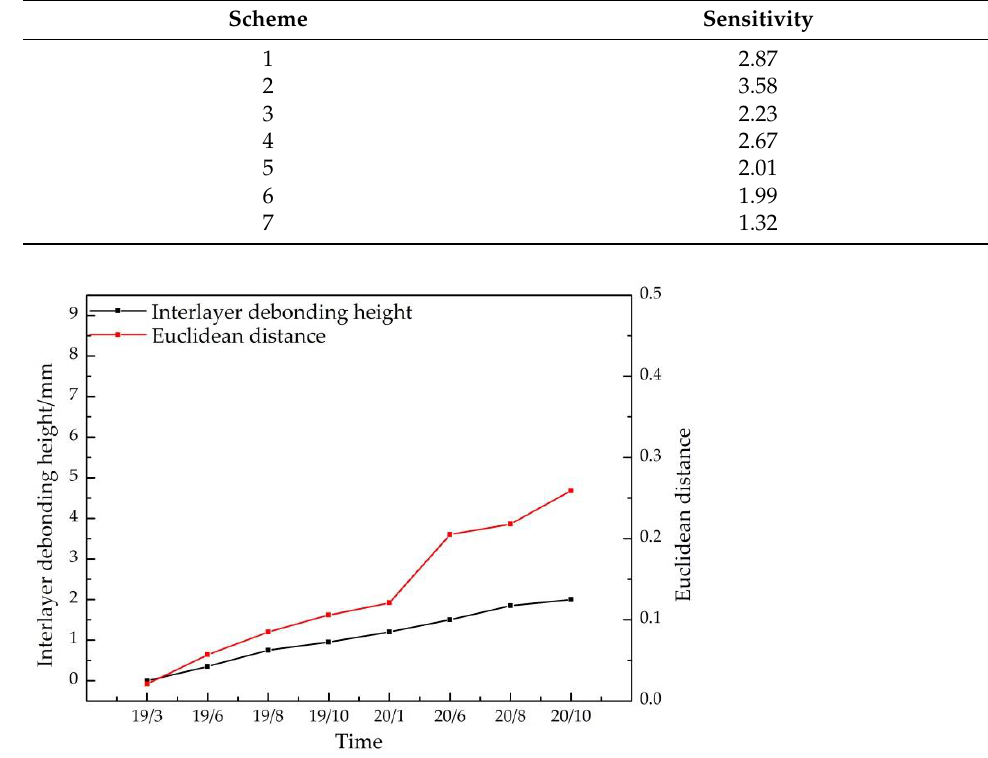
Figure 23. Variation of interlayer debonding and Euclidean distance with time.